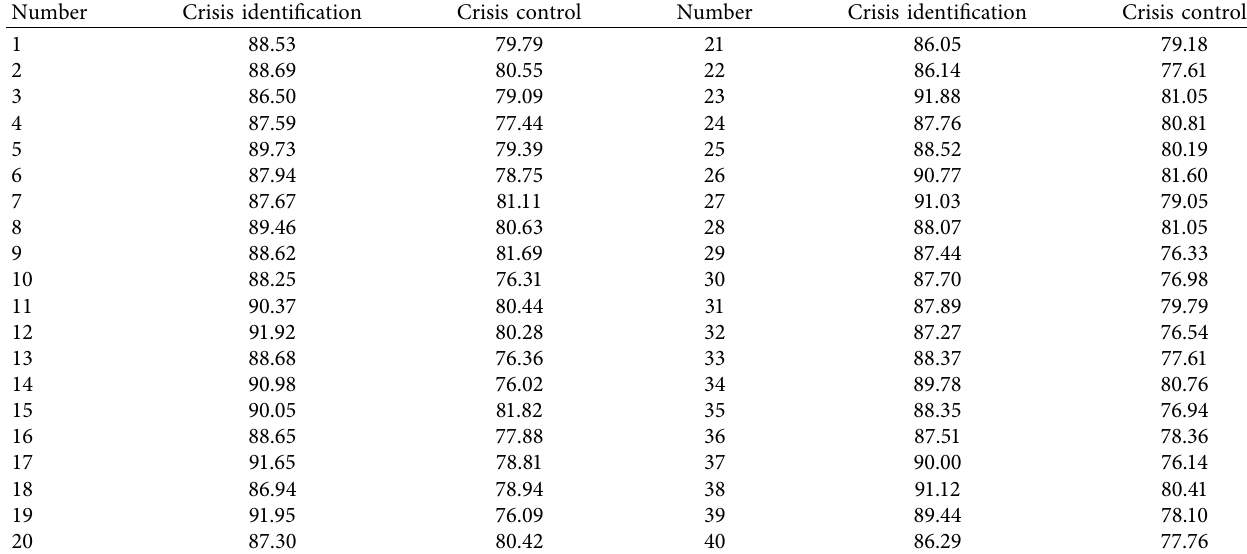
Table 1: The identification effect and the control effect of the crisis propagation mode based on the social network.